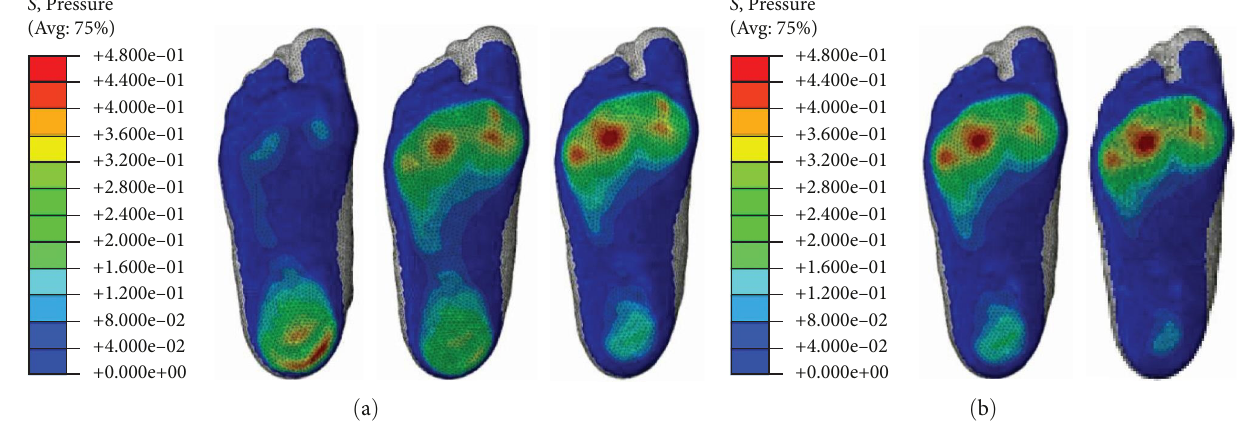
F IGURE 6: Plantar pressure distribution (a) at t 1 , t 2 , and t 3 gait instants in RFS jogging (from left to right) and (b) at t 2 and t 3 gait instants in FFS jogging (from left to